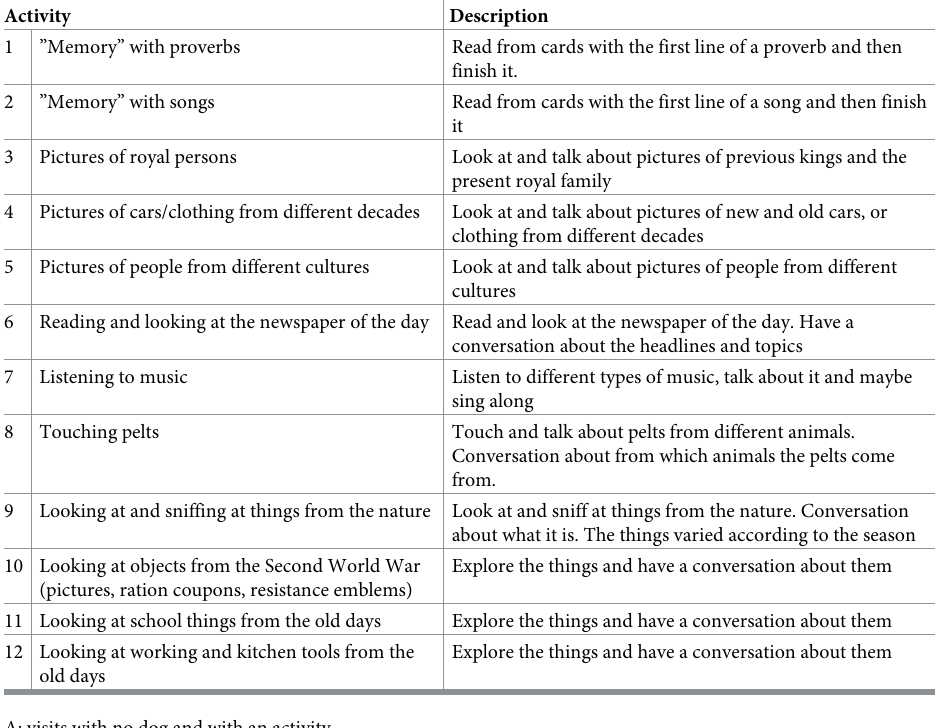
Table 2. Description of the 12 different activities used in visit type